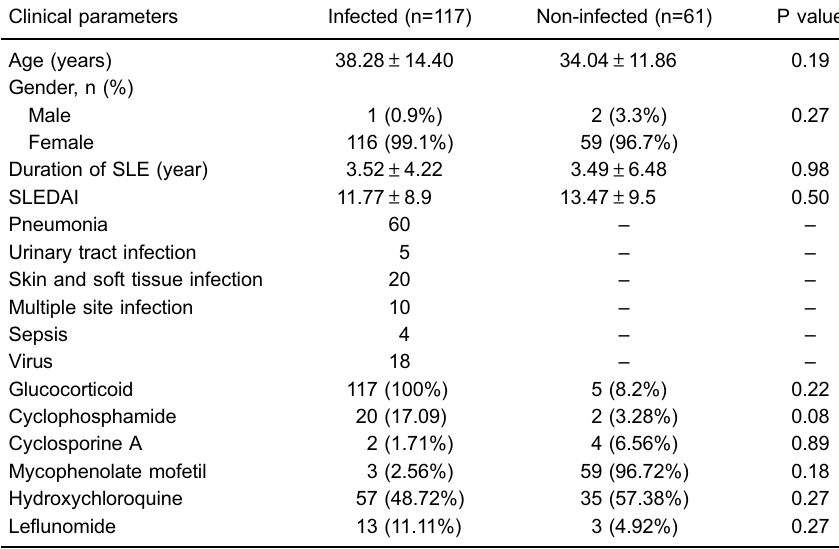
Table 1. Demographic data and clinical characteristics of SLE patients